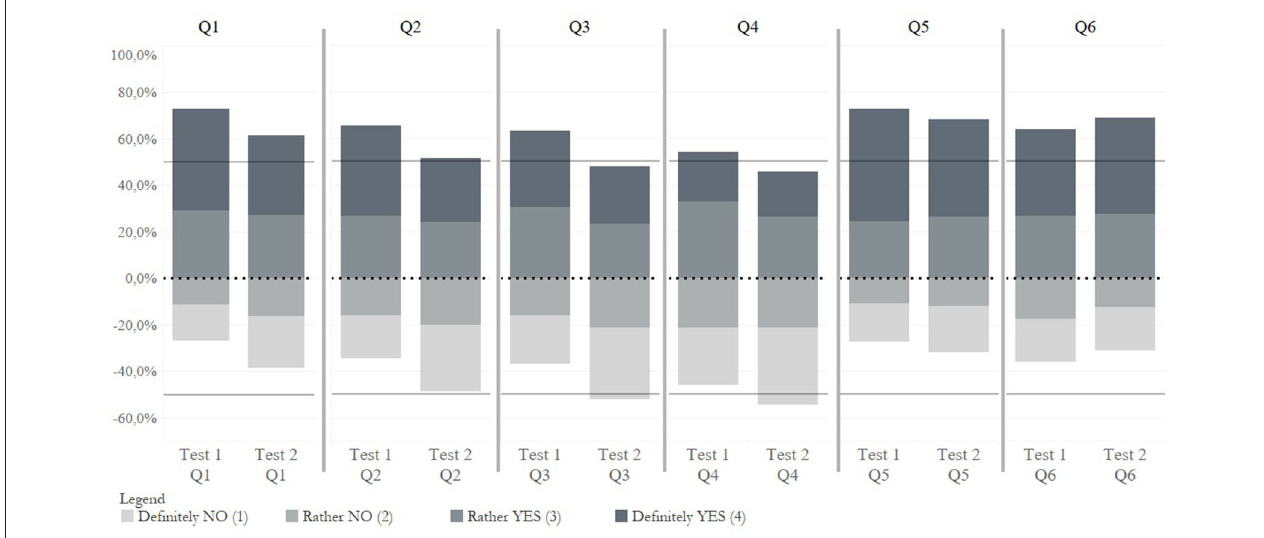
FIGURE 1 | Visualization of COVID-19 testing perceptions–the first test and the last